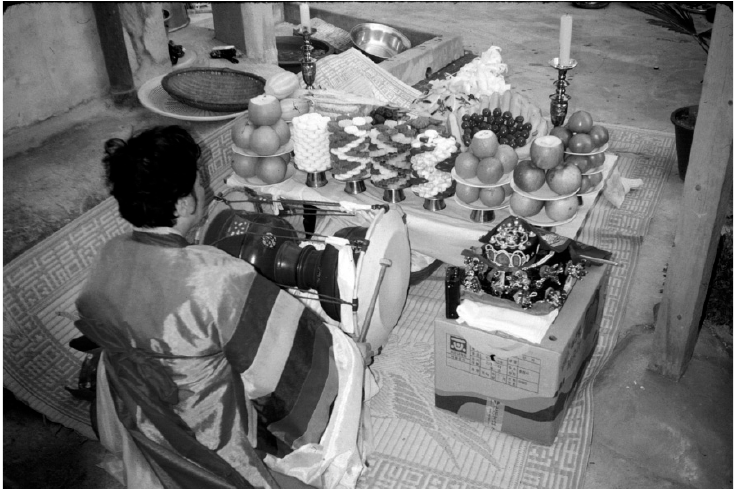
Figure 6. A Mansin performs a kut for the dead in front of an offering tray. Bananas and tomatoes have been added to a traditional display of apples, pears, and carefully constructed towers of traditional sweets. In 2003, the crown to the right of the mansin is more elaborate than it would have been in the 1970s. Photograph by author.